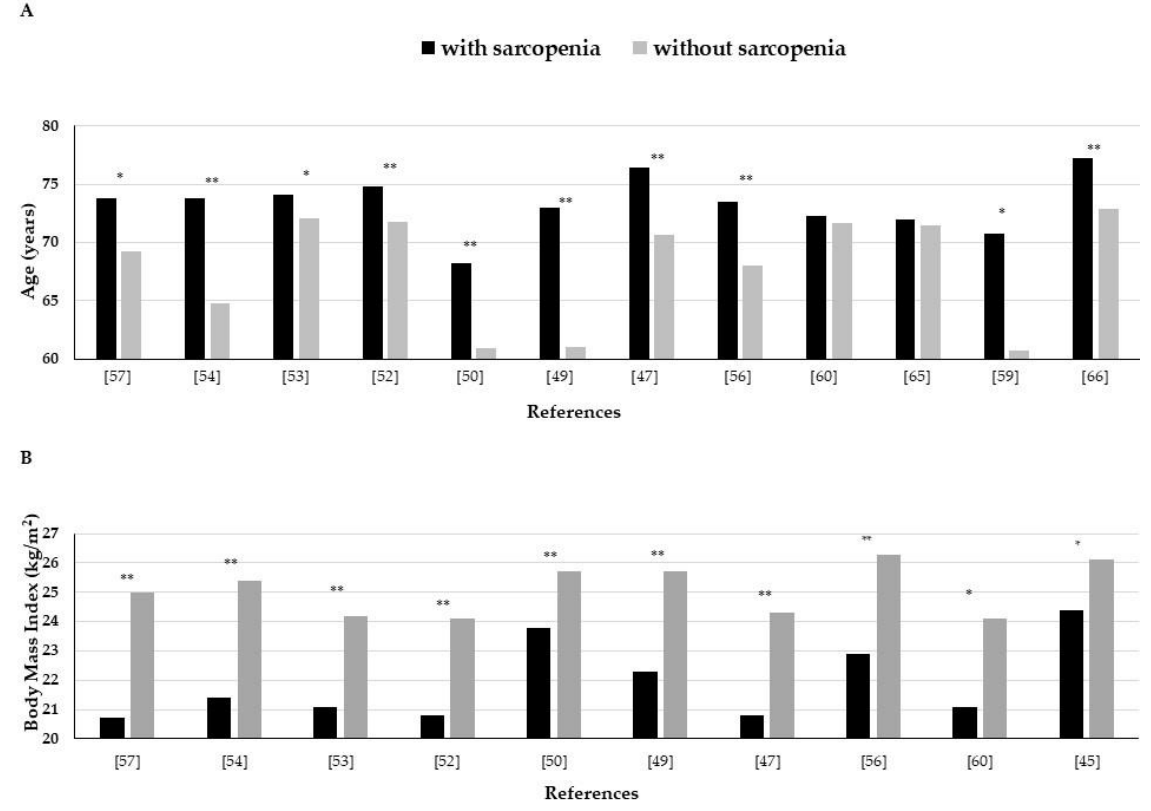
Figure 1. Mean values of age ( A ) and body mass index ( B ) in type 2 diabetes mellitus individuals with and without sarco- penia in epidemiological studies. * p < 0.05; ** p < 0.001.